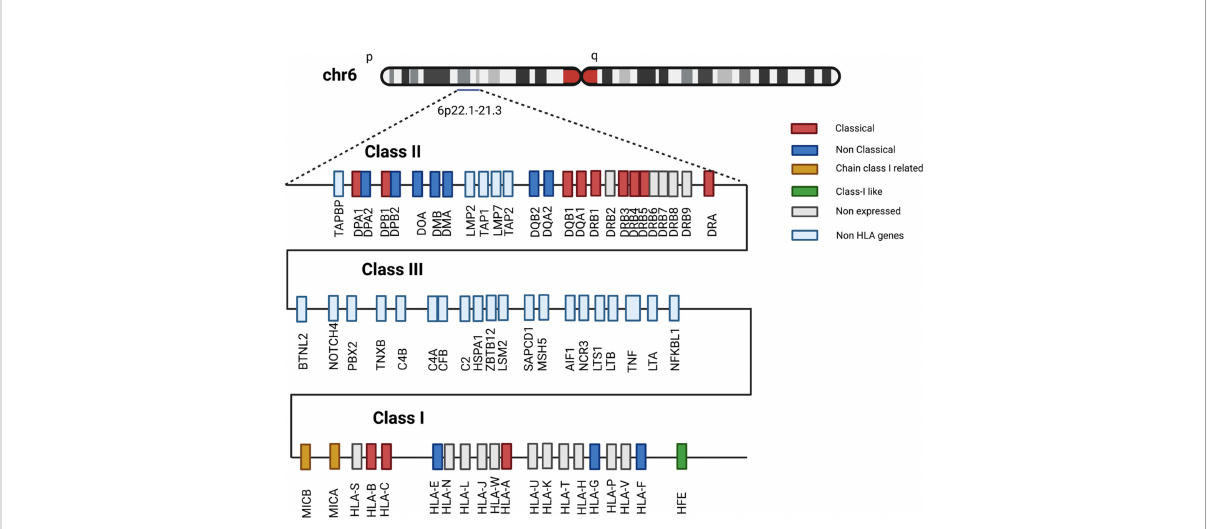
FIGURE 2 Schematic structure of the human MHC region. Selection of class I, II and III HLA and non-HLA genes located in 6p22.1-21.3 region. Gene-locus classi fi cation reported in legend follows IPD-IMGT/HLA database description. Distances among genes not to